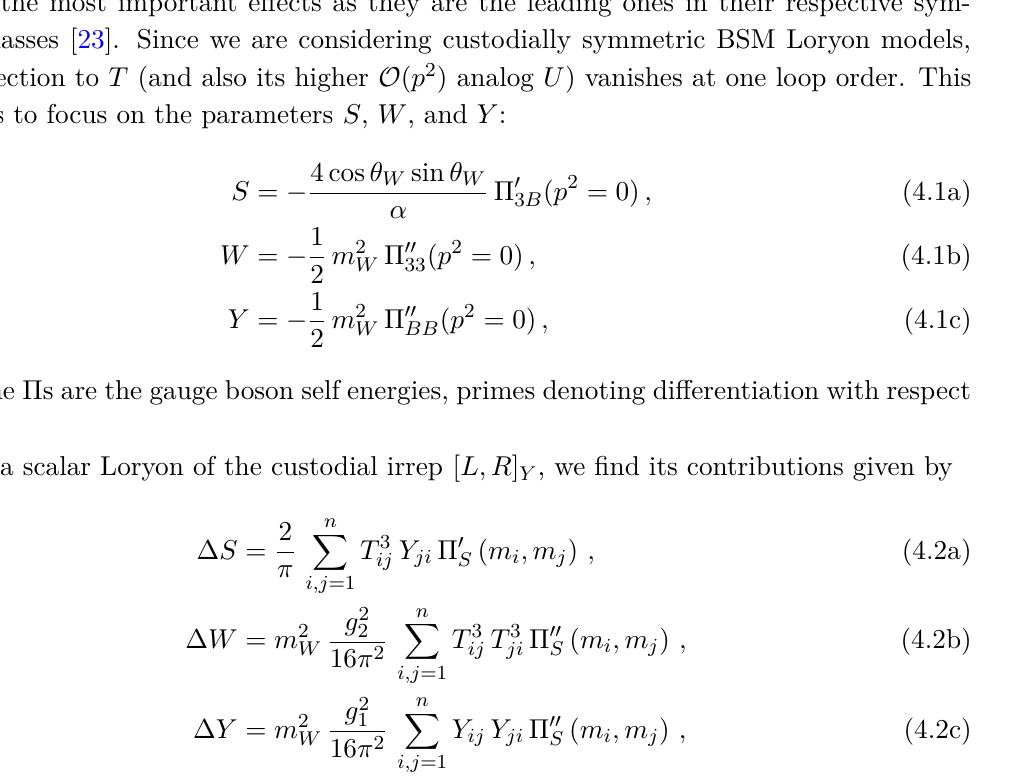
Figure 6 . Allowed region (unshaded) in the mass vs P f 2 (scalar) particles whose mass is less than half the Higgs mass, arising from the upper limit on the Higgs branching ratio to ‘untagged’. The plot assumes all new particles have the same